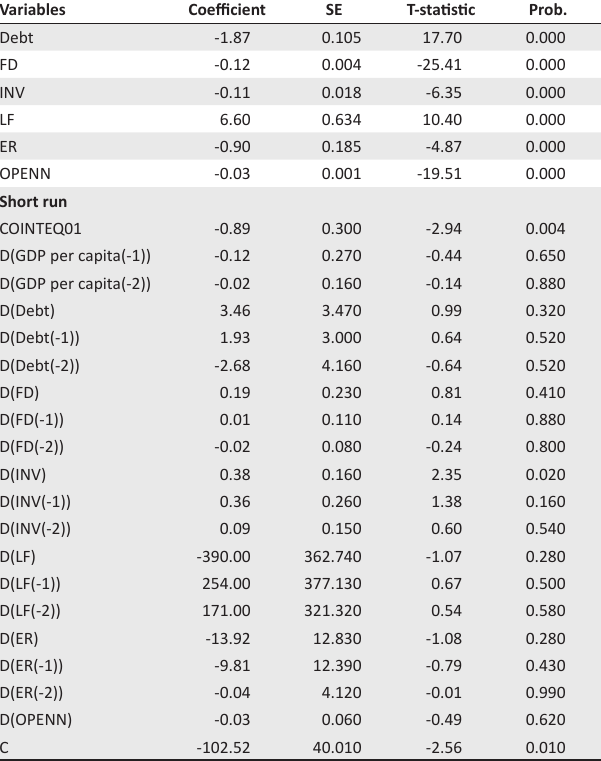
TABLE 6: Pool mean group results. Variables